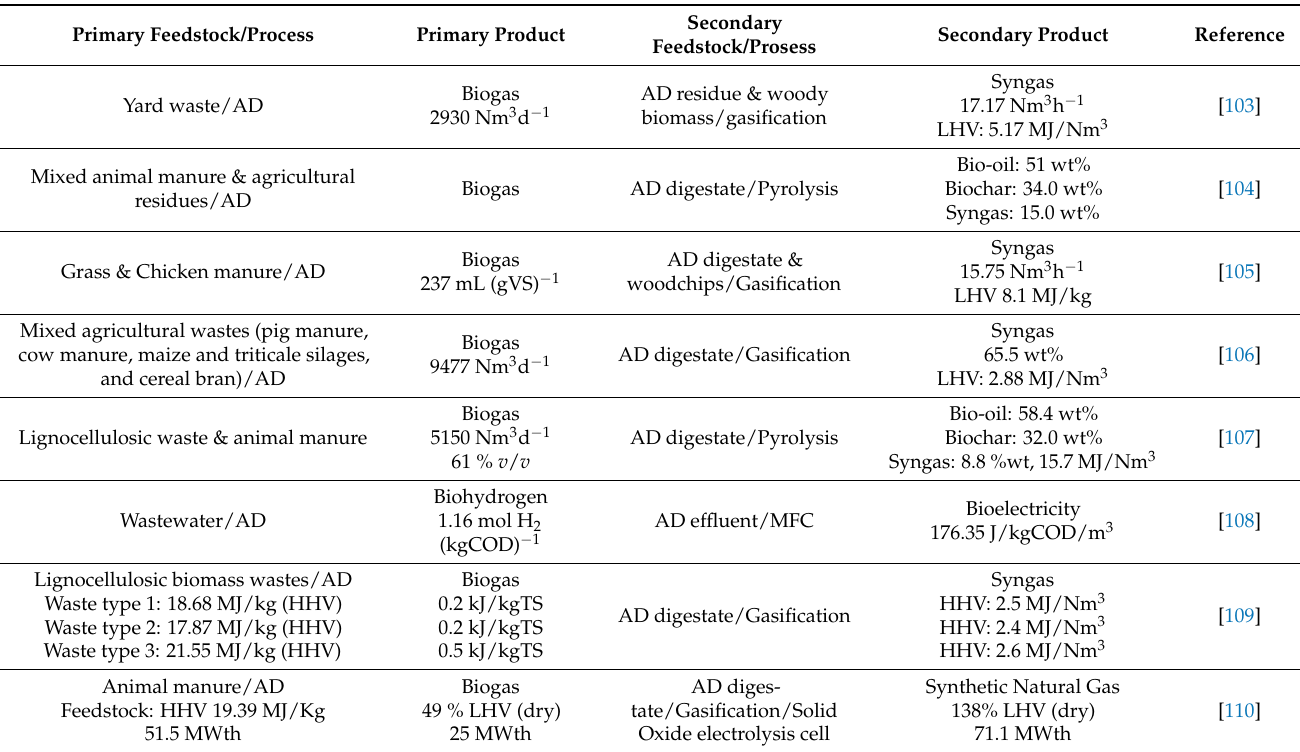
Table 2. Examples for biorefinery integration based on the exchange of waste/by-product.